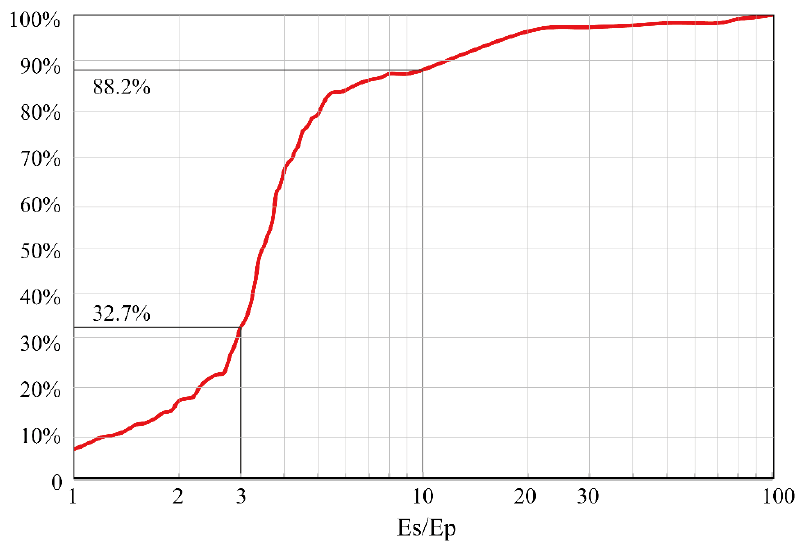
Figure 9. Distribution of the ES/EP value of MS events.